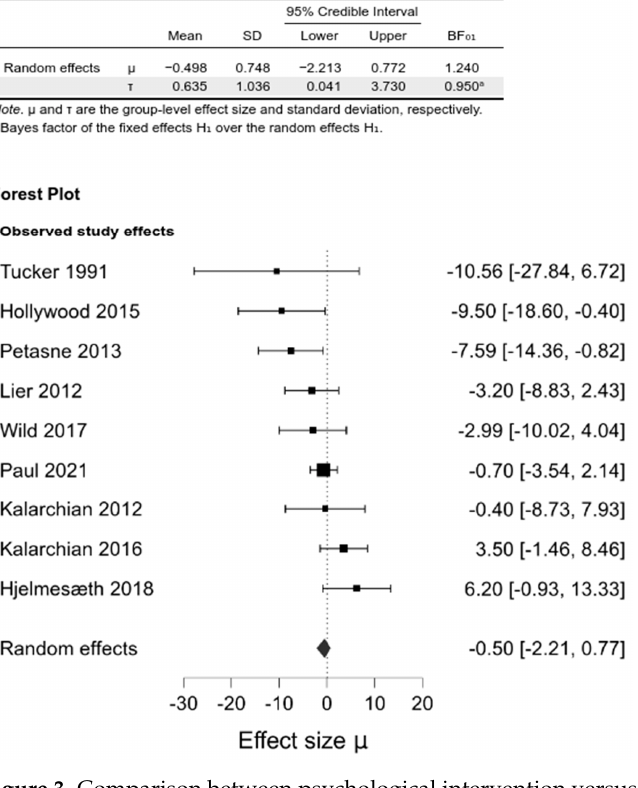
Figure 3. Comparison between psychological intervention versus any control in the WL at the last follow-up. Upon performing meta-analysis, we did not observe any differences in percentage WL between the intervention and control groups at any follow-up time-point ( − 1.60 [ − 4.68, 1.48], − 0.54 [ − 2.79, 1.07]; BF 01 = 1.17, − 1.06 [ − 4.53, 0.92]; BF 01 = 0.88, for 6–12 months, 1–2 year, and the last follow-up, respectively).